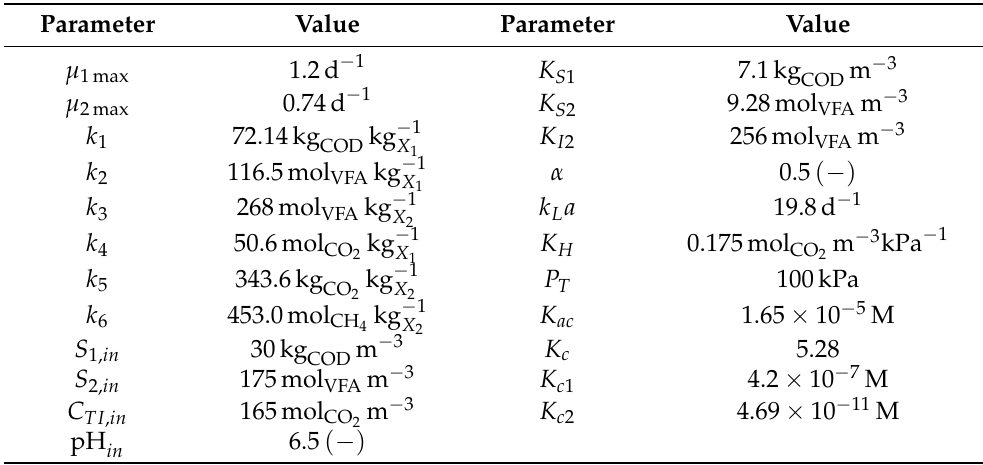
Table 2. Parameters for the simulation of the modified AM2 model [33]. The values of the physico- chemical equilibrium constants are at standard